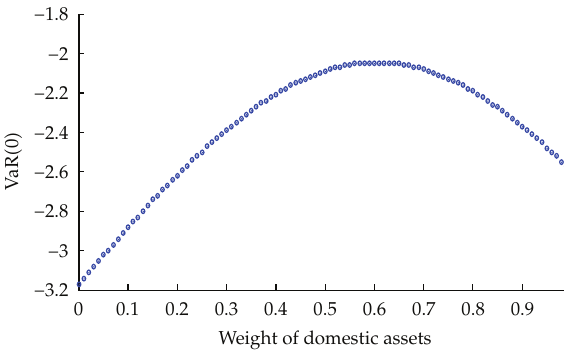
Figure 4: The impact of weights of domestic assets on